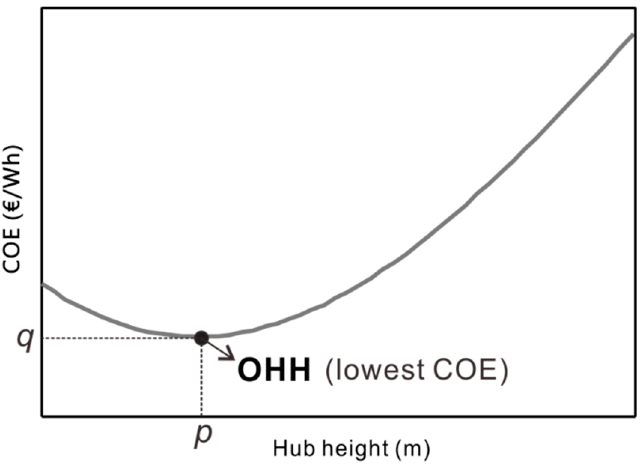
Figure 2. Cost of energy (COE) curve as a function of hub height hub height (HH). OHH, optimal hub height.